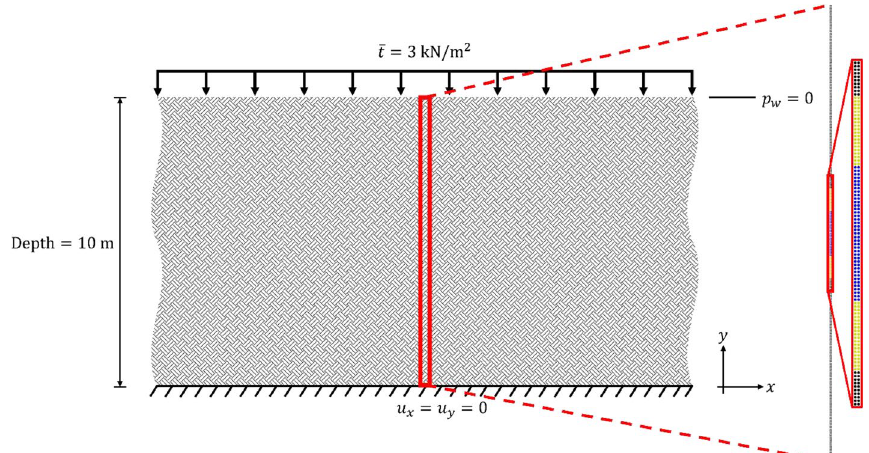
Fig. 6 Poroelastic wave propagation in soil with infinite dimension in x‑direction and is discretized by coupled Lagrangian/semi‑Lagrangian RK points in the y‑direction; Lagrangian (black nodes), semi‑Lagrangian (blue nodes), and transition (yellow nodes) regions for coupled L–SL